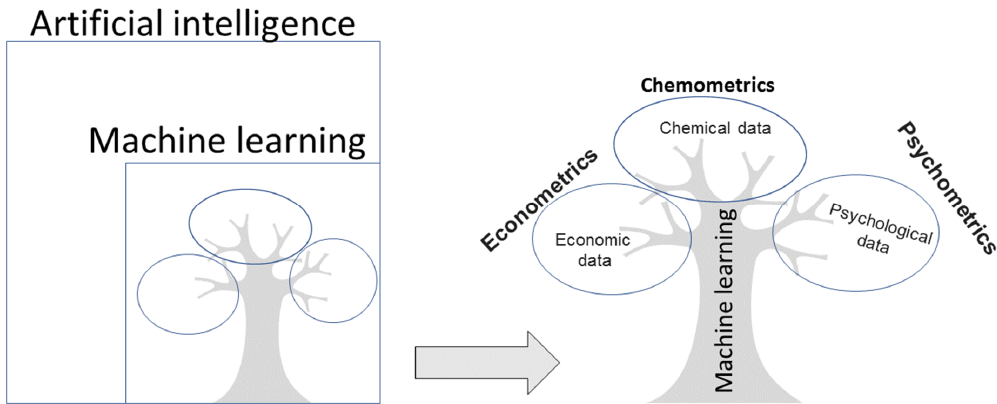
Figure 1. Machine learning (ML) is subset of Artificial intelligence (AI) and Chemometrics is machine learning used in chemistry.